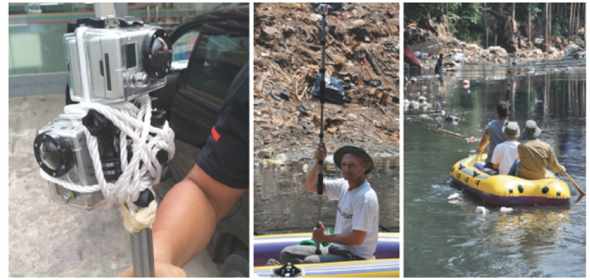
Figure 3: Three GoPro HD Hero2 cameras, mounted on a tele- scopic mast. Balancing the camera set-up in the middle of the boat. (Photos: Rekittke et al.,